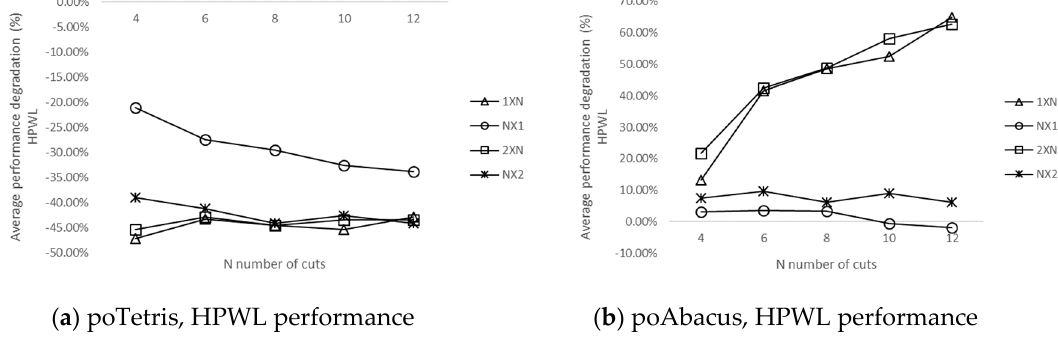
Figure 5. Solution quality performance comparison for different partitioning alternatives.